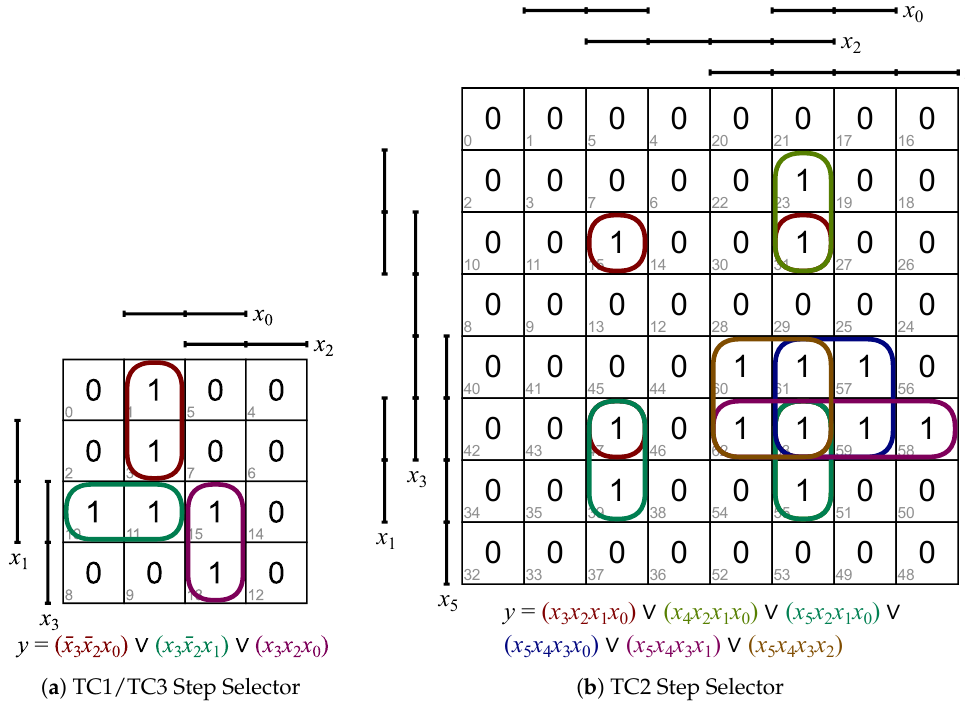
Figure 3. Selecting Relevant Steps with KV-Maps Figures were created with the online tool from https: //www.mathematik.uni-marburg.de/~thormae/lectures/ti1/code/karnaughmap/, last visited 30 May